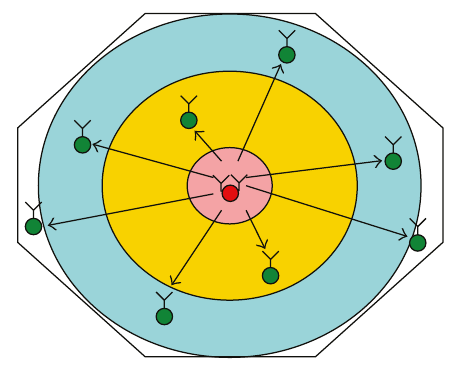
Figure 1: Cellular downlink